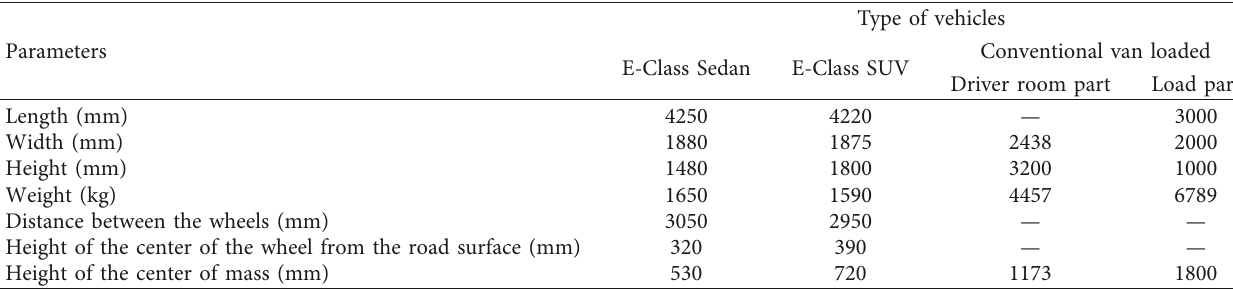
Table 2: Specifications of the vehicle used in the research.